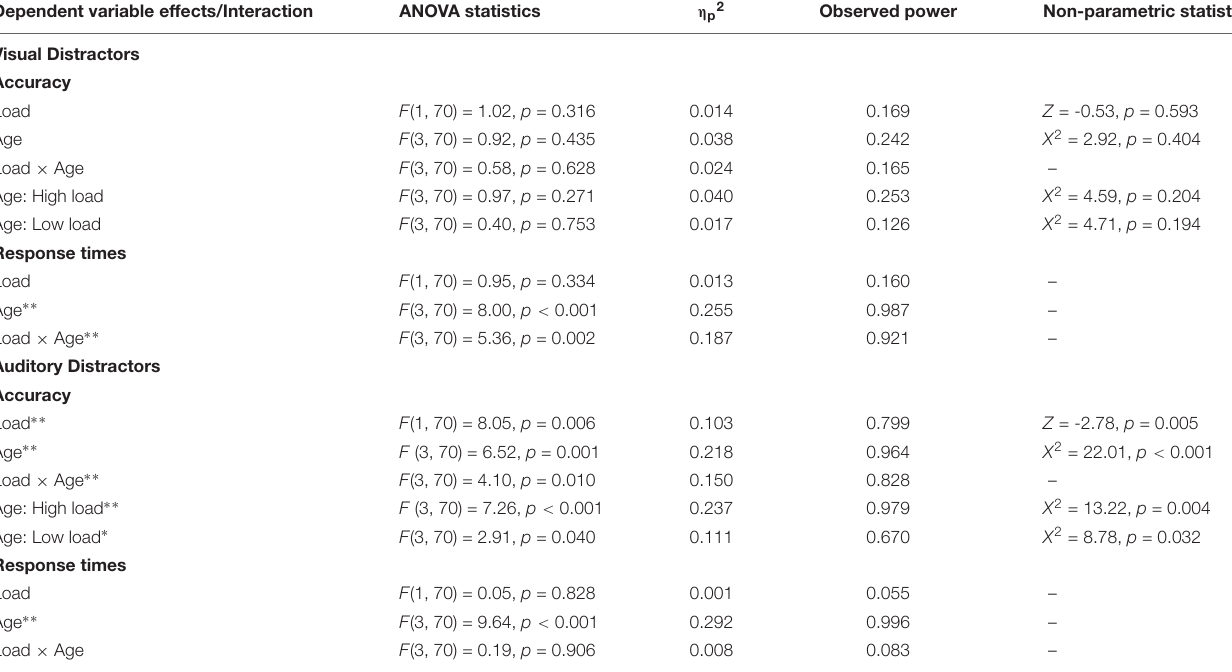
TABLE 2 | Age × Load mixed-factors ANOVA examining effects of visual distractors on accuracy/response times (top) and effects of auditory distractors on accuracy/response times (bottom).